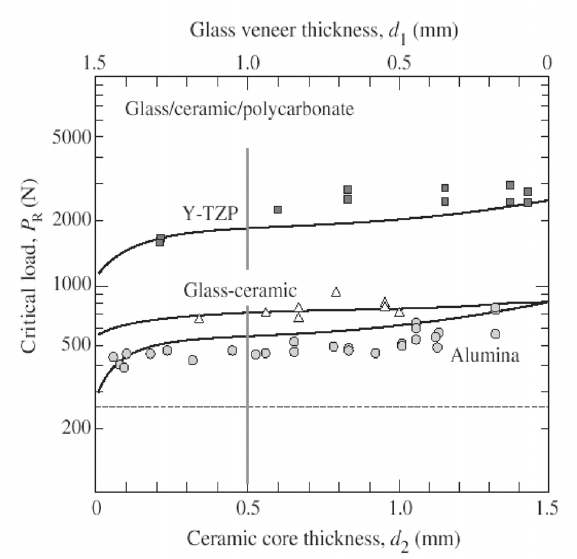
FIGURE 5 - Critical loads P for inner core radial cracking R as function of outer veneer thickness d (or inner thickness 0 d ), for trilayers with common soda-lime glass outer layers i and indicated inner core ceramic layers. Results for fixed net thickness d = d + d = 1.5 mm. Data points are o i experimental data, solid curves are theoretical predictions. Vertical bars represents standard 0.5 mm thick structural ceramic core